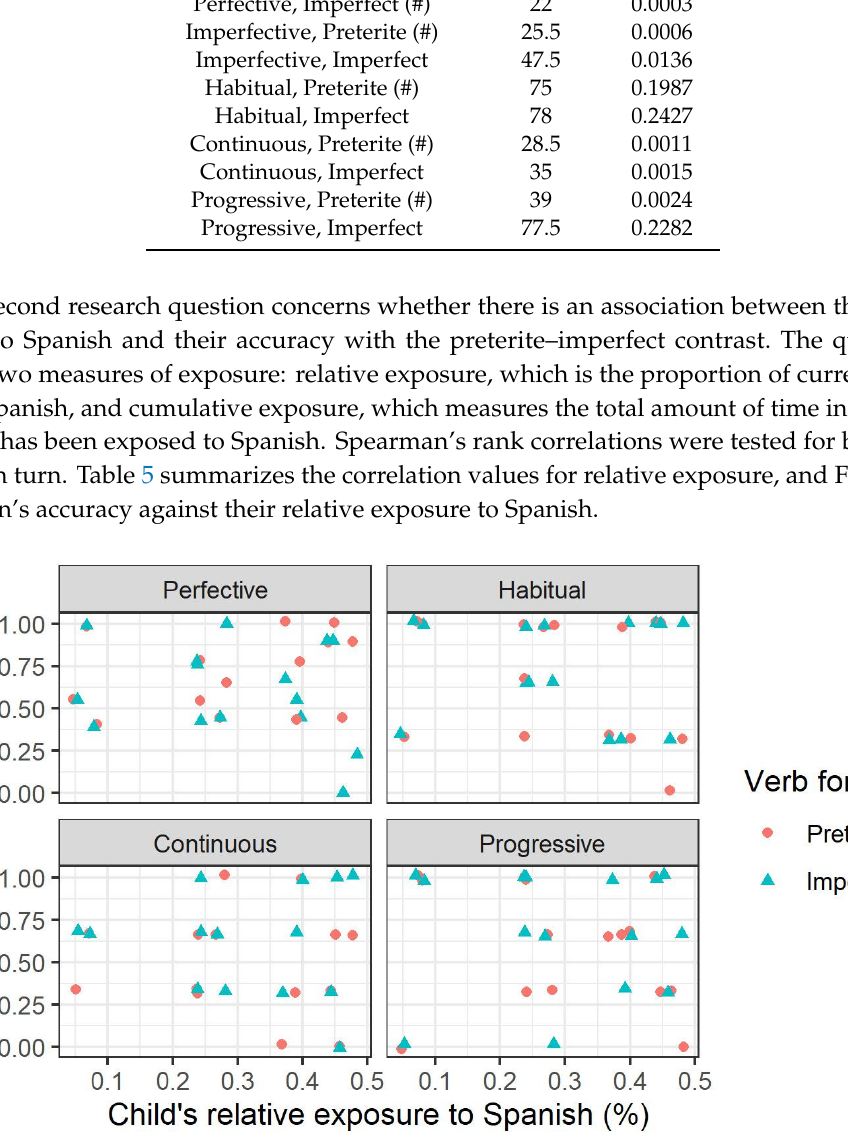
Figure 3. Children’s relative exposure to Spanish and their accuracy for each morpheme in four contexts (perfective, habitual, continuous and